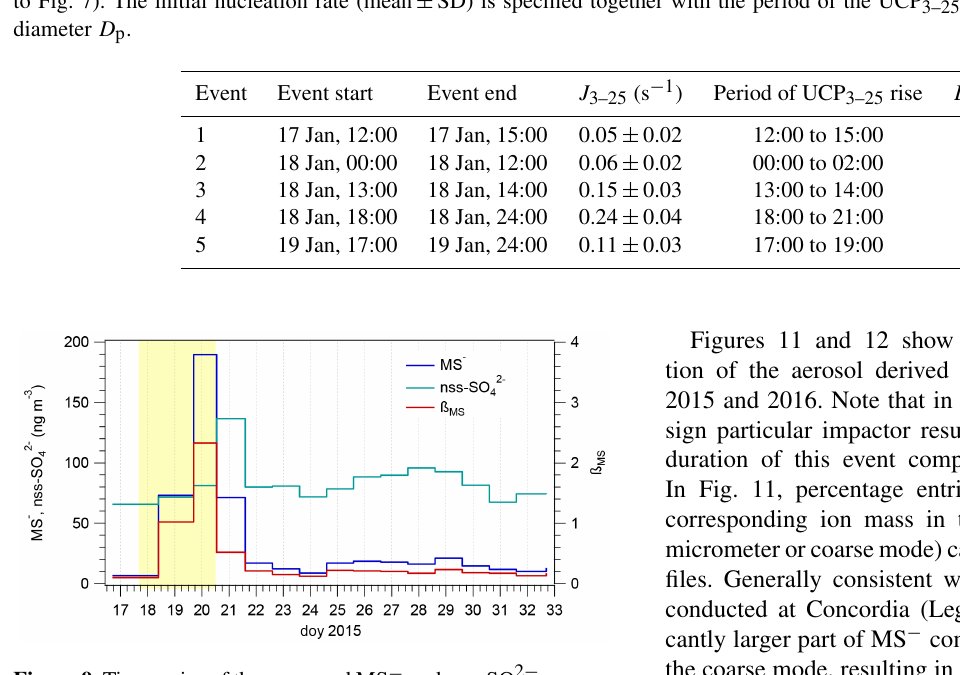
concen- 4 mass ratio β MS from bulk 4